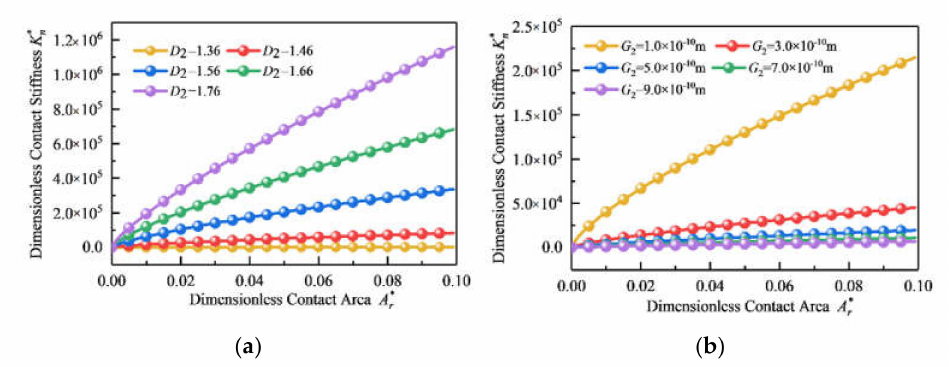
Figure 14. Variations in the dimensionless contact stiffness K ∗ n with the dimensionless contact area A ∗ r : ( a ) different fractal dimensions D ; ( b ) different fractal roughness G .